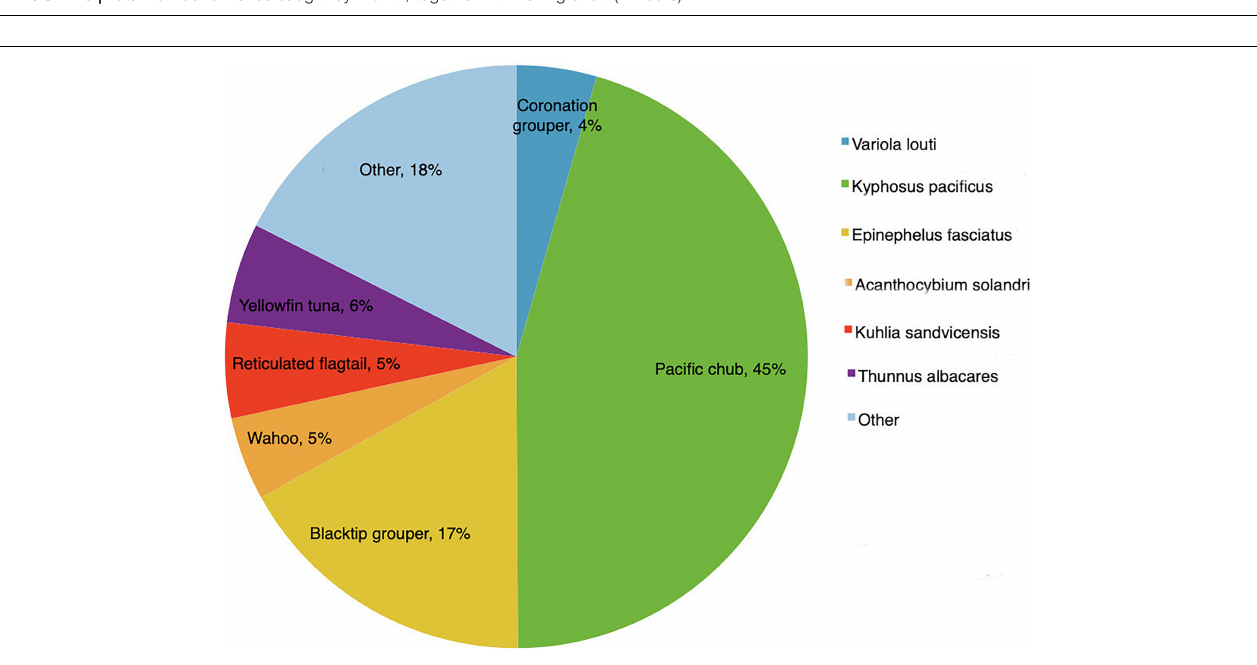
FIGURE 8 | Total number of fishes caught by month, together with fishing effort (in hours).